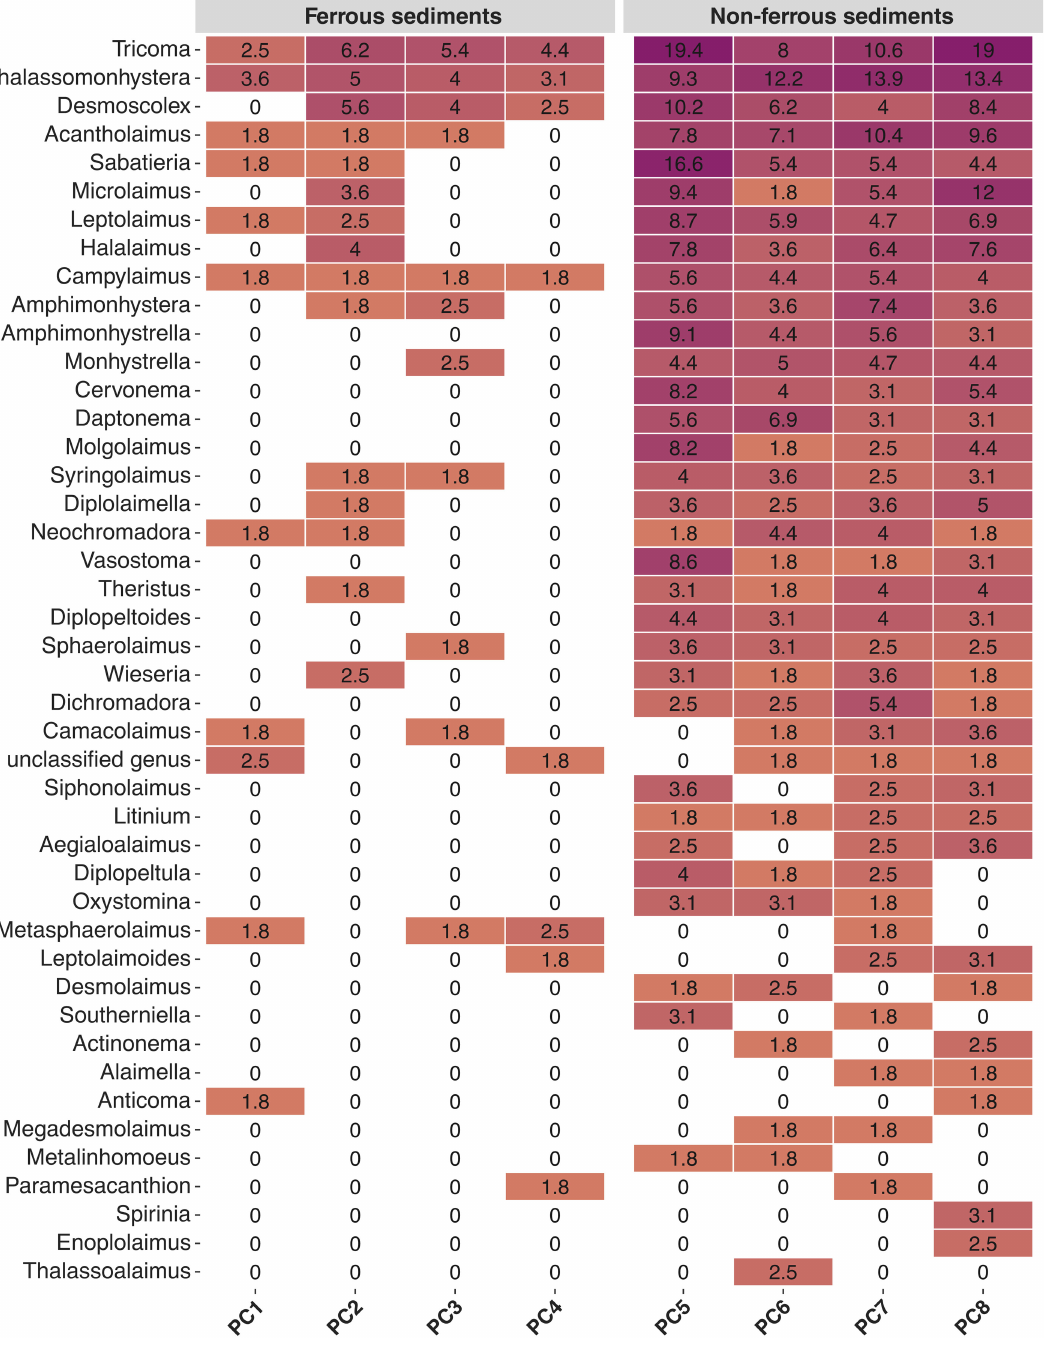
TABLE 3 Nematode community composition at genus resolution. Heatmap of the dominant community members along the sampled transect. Displayed are average abundances for individual taxa per push-core, integrating the surface sediment from 0-5 cm depth. Only genera with a minimum relative abundance of 2% are